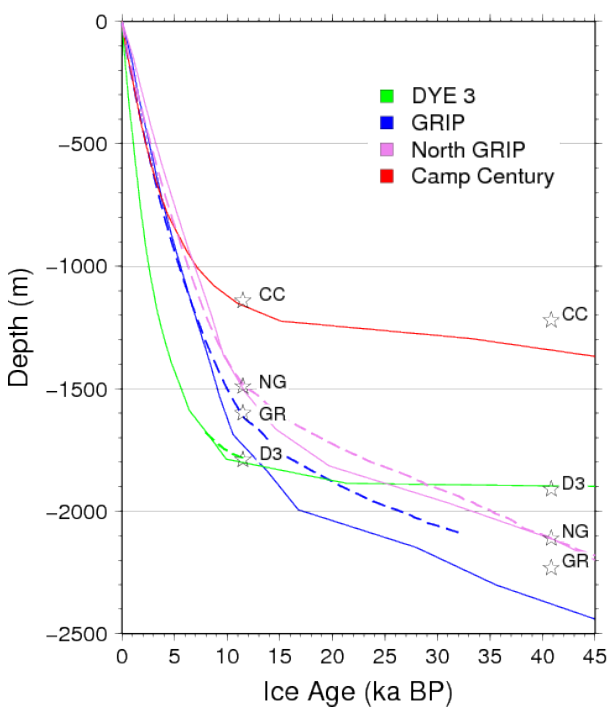
Fig. 5. Simulated age-depth relationship after calibration (plain line) and GICC05 (dashed lines) for four deep ice cores. The common GICC05 timescale is mainly available for GRIP and North GRIP for the long record, and for Dye 3 for the early Holocene. The stars represent the approximate depths of the Younger Dryas (approx. 11.5 ka BP) and the Laschamp event (approx. 40.8 ka BP). We mainly improve on the North GRIP dating with our calibration, as this record is used both as a forcing (age- δ 18 O) and as a constraint (age-depth). 33